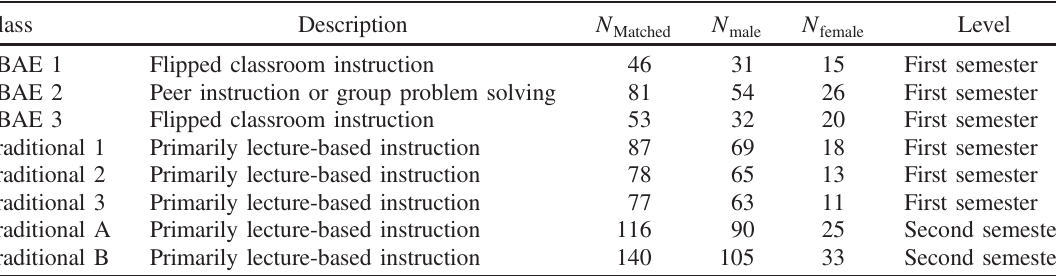
TABLE II. A summary of the descriptions of the manner in which each class was taught. We conducted the initial analysis without matching students from pre to post and then performed matched data analysis by matching students from pre to post. We found that the matched analysis was not statistically significantly different from the unmatched analysis so we only discuss matched analysis here. Thus, the numbers listed for matched students ( N students included in further analysis. Average loss of students from unmatched to matched in different classes was 19%, and includes losses due to students who dropped or withdrew from the class, were absent for the pre- or postsurvey, e.g., due to adding the class late and missing the presurvey, or choosing not to complete the pre- or postsurvey. The number of matched male and female students is also included. Note that sometimes gender was not indicated by a student. In that case, provided the students had both pre- and postdata, they would have been included in the overall analysis, but not included in the analysis of differences by gender. Thus N always equal N Matched